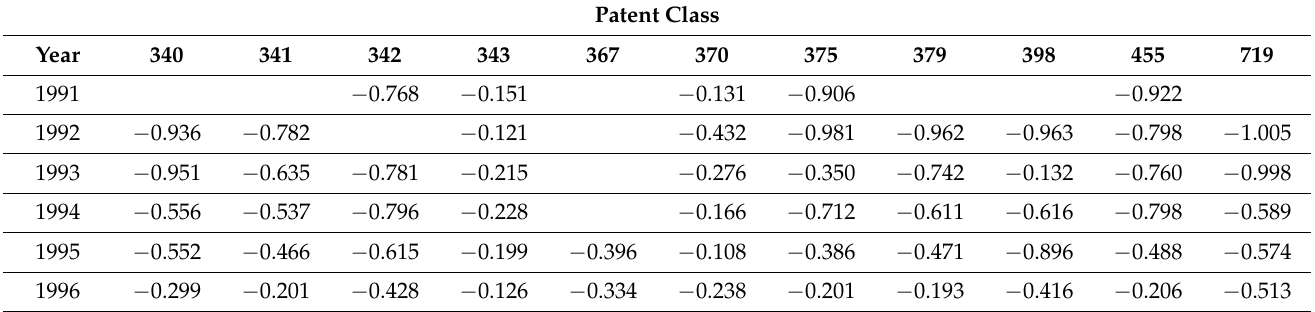
Table 4. Follow the leader when all firms have different leaders in the same year (e.g., α